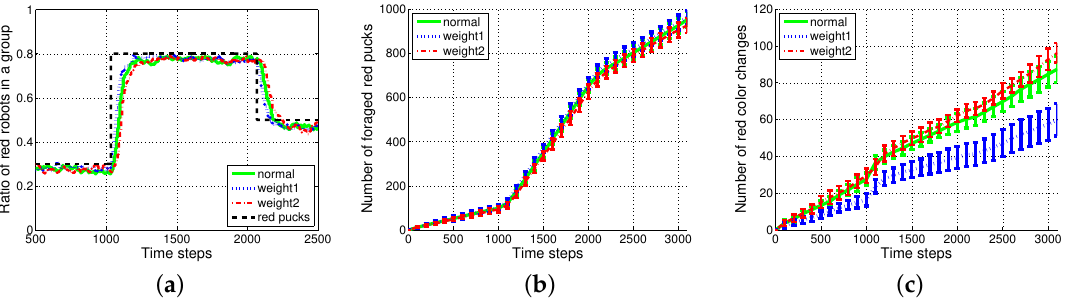
Figure 10. Results of weighted History 1 ( L = 10 ) . ( a ) Ratio of red robots in a group; ( b ) number of foraged red pucks; ( c ) number of red color changes.